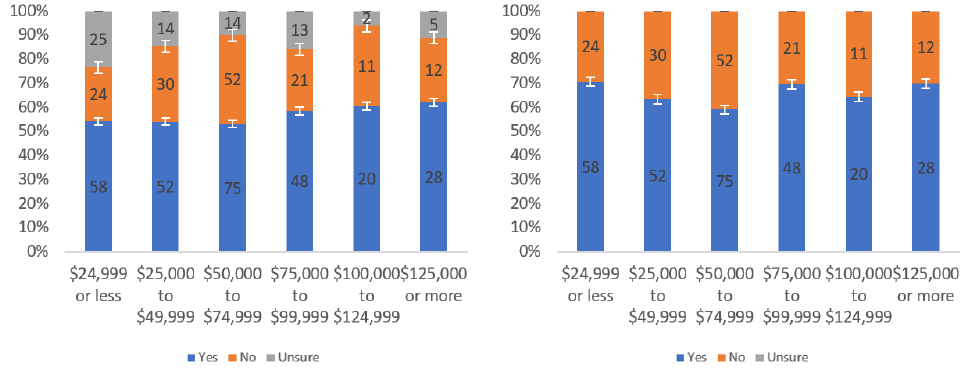
Figure A22. Responses regarding respondents’ willingness to review by income level including ( left ) and excluding ( right ) unsure responses.